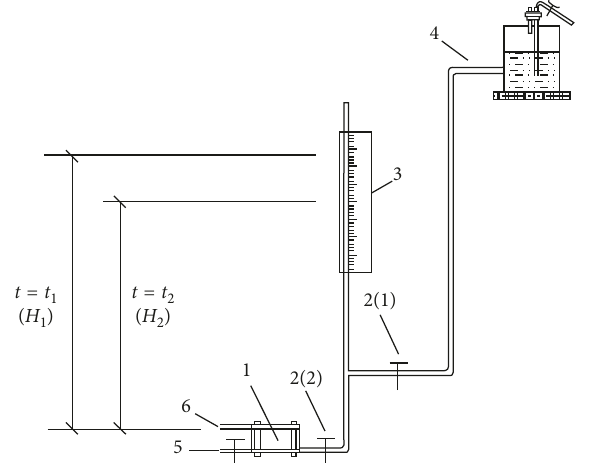
Figure 6: Schematic diagram of the variable head permeability test.